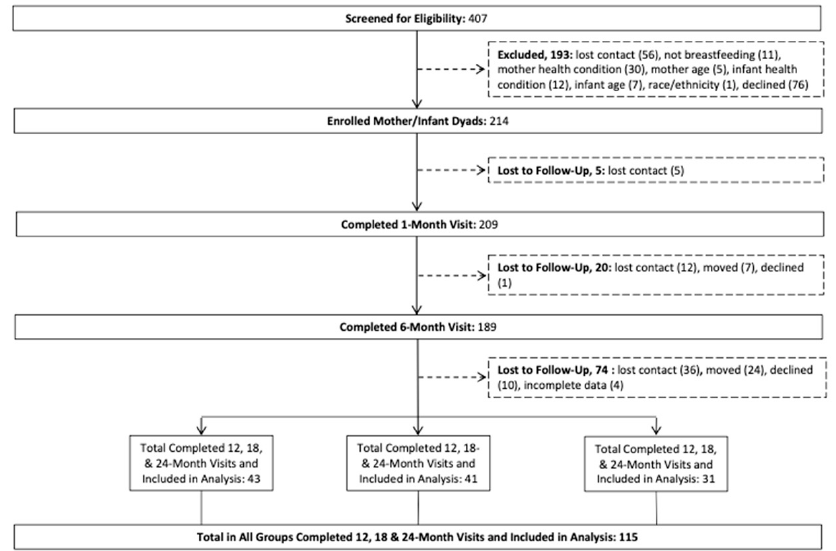
Figure 1. Participation flow chart and distribution of participants to infant feeding type groups.